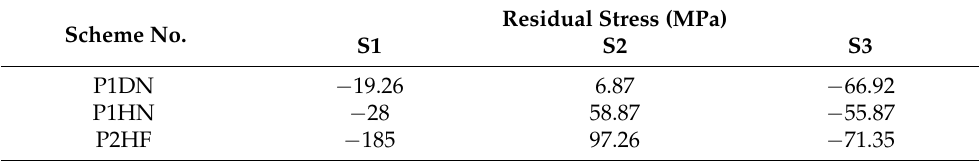
Table 5. Residual stress of three castings. Scheme No.